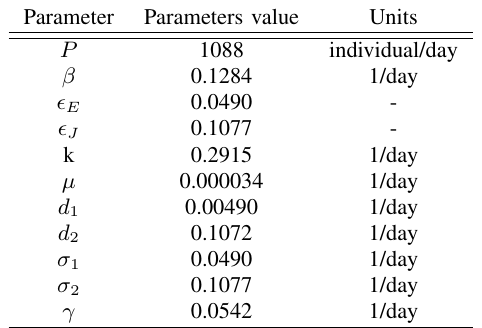
TABLE II: Model parameter for Saudi Arabia, the case R c = 1 . 004 .